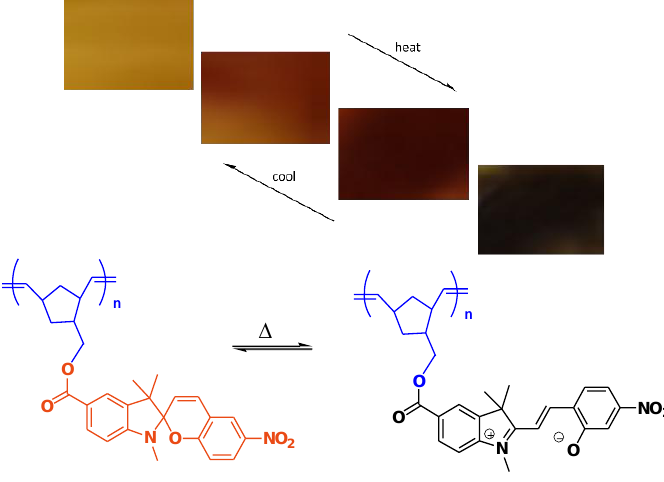
Figure 2. Thermochromic behavior of polymer 9 .